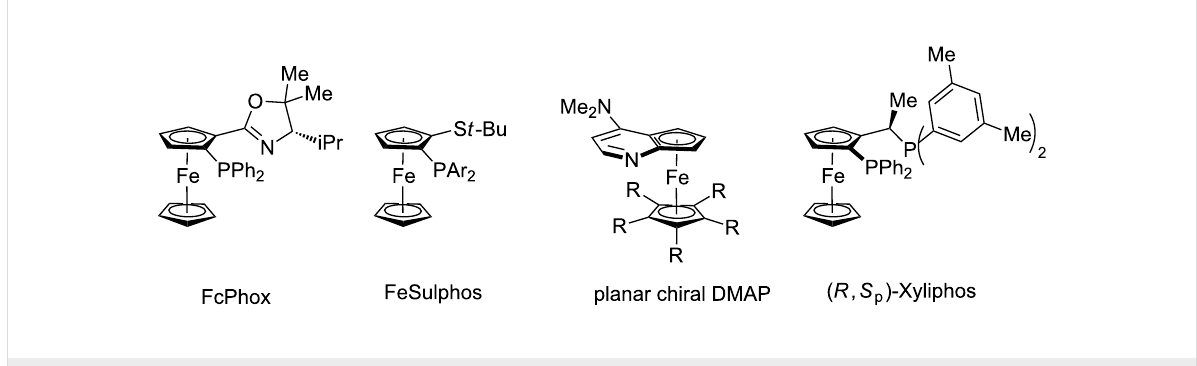
Figure 1: Selected ferrocene-based ligands and organocatalysts.